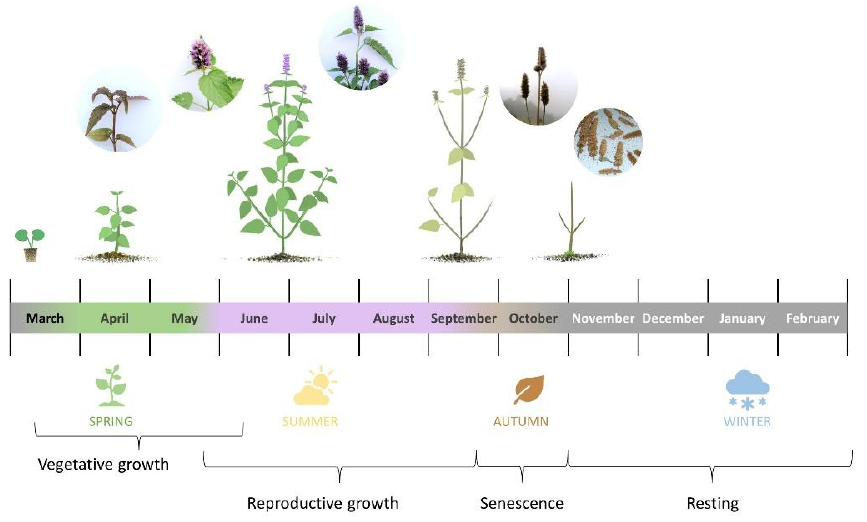
Figure 5. Main phenophases and life cycle of Agastache in Cluj-Napoca, Romania (original).